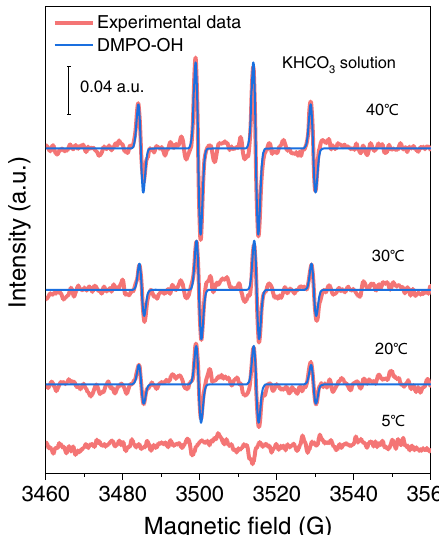
Fig. 3 Temperature-dependent EPR spectra from 5 to 40 °C. EPR data were recorded in Ar-saturated 0.5 M KHCO 3 solutions containing 100 mM DMPO without pre-reduction operations. Each spectrum was acquired after 8 h resting at the indicated temperature.